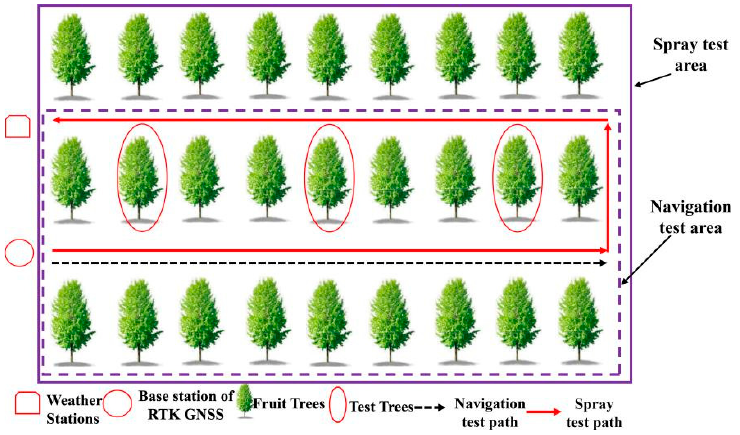
Figure 11. Schematic diagram of the test.